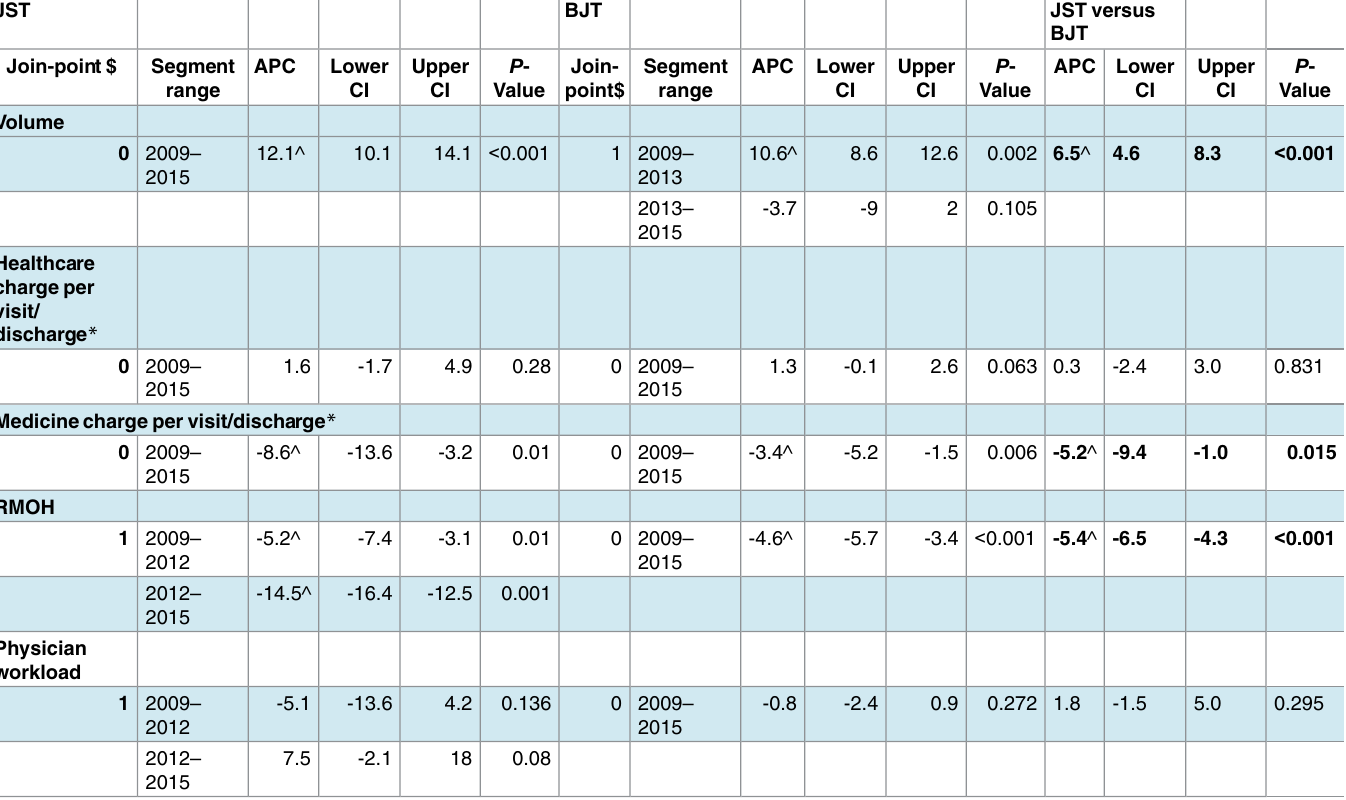
Table 4. The inpatienteffectsassociatedof the zero-markup drugpolicy implementedin Dec 2012 at the Jishuitan Hospital at Xinjiekou campus, Beijing,Chinain comparison withthe Beijingtertiaryhospitals. JST BJT JST versus